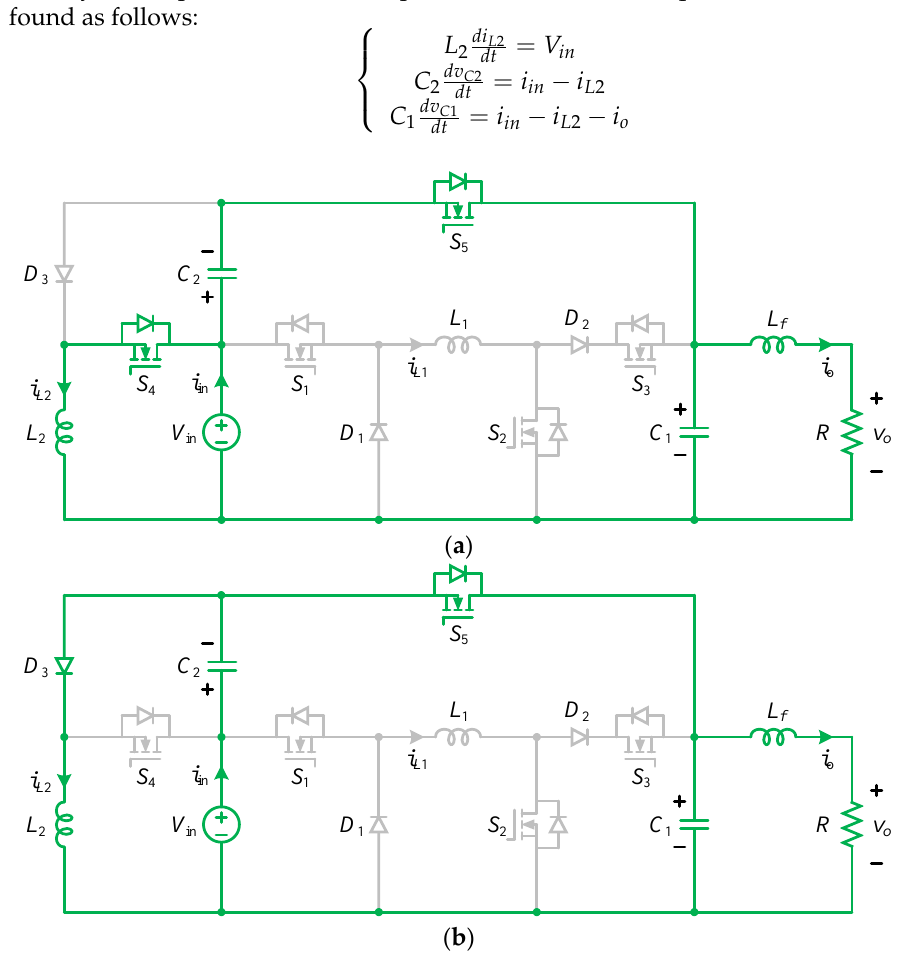
Figure 5. Equivalent circuits of the proposed CGBBI topology in interval 3 when v o < 0: ( a ) mode 1 and ( b ) mode 2.